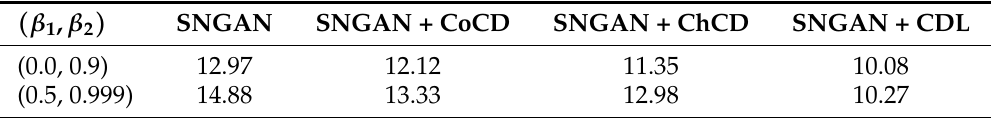
Table 2. FID scores (lower is better) among SNGAN, SNGAN + CoCD, SNGAN + ChCD, and SNGAN + CDL on CelebA-HD. “SNGAN + CoCD” means combining SNGAN with the consistent contrastive distance, “SNGAN + ChCD” means combining SNGAN with the characteristic contrastive distance, and “SNGAN + CDL” means combing SNGAN with contrastive distance